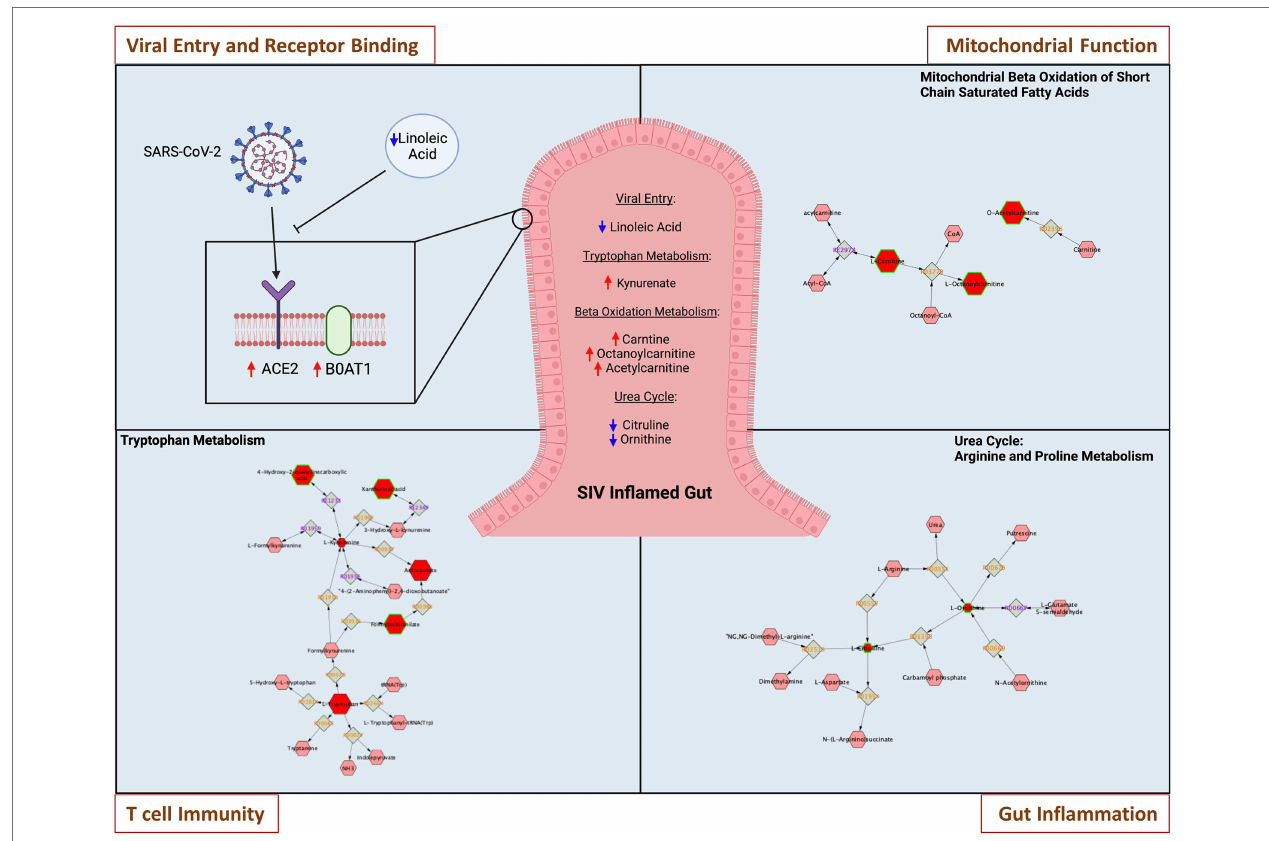
FIGURE 6 | Metabolic changes in the gut during SIV infection increase vulnerability to SARS-CoV-2 infection. Representative networks of metabolites in key pathways are highlighted. SIV induced metabolic changes within inflamed gut directly impact on SARS-CoV-2 viral entry and receptor binding through modulations of linoleic acid and tryptophan transporter-B0AT1. Metabolic pathway of mitochondrial beta oxidation of short chain saturated fatty acids is altered in SIV inflamed gut, leading to mitochondrial malfunction. Tryptophan metabolism is modulated to impair T cell immunity, and dysregulated urea cycle of arginine and proline metabolism leads to intestinal inflammatory